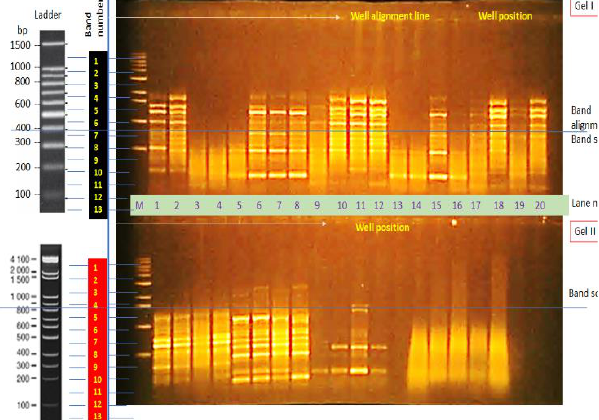
Figure 1 . Gel band scoring scale used in MS PowerPoint for gel image analysis one by one To determine robustness of the dendrogram, the data were bootstrapped with 1000 replications.